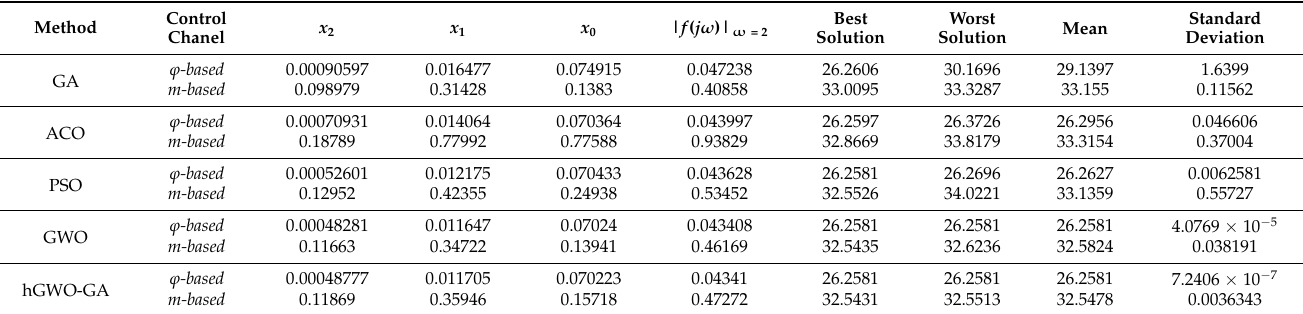
Table 6. Parameters of robust SSSC-based stabilizer of IEEE 4-Machine Power System.